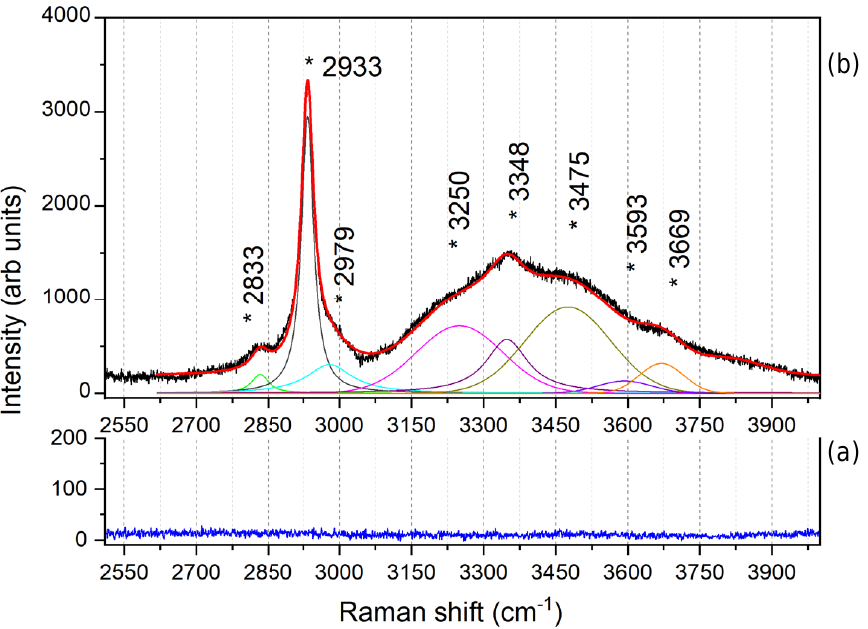
Figure 6. Comparison between the ( a ) reference spectrum of the featureless bare Ag dendrites (blue line) and ( b ) that one of ssRNAs of the SARS-CoV-2 Omicron variant (black line) in the region between 2500 and 4000 cm − 1 , fitted (red line) considering the contributes described in the text. The colored lines in ( b ) are the fitting curves separating the different spectral contributions. In particular, the green-, dark grey-, and cyan-colored lines represent the C-H stretching contributions; the magenta (at 3250 cm − 1 ), the dark yellow (at 3475 cm − 1 ), and the violet (at 3593 cm − 1 ) lines represent the network, intermediate, and multimers water bands, respectively, as described in the text. The purple and orange lines indicate the N-H stretching band of nucleobases (at 3348 cm − 1 ) and the ribose O-H stretching band (at 3669 cm − 1 ),